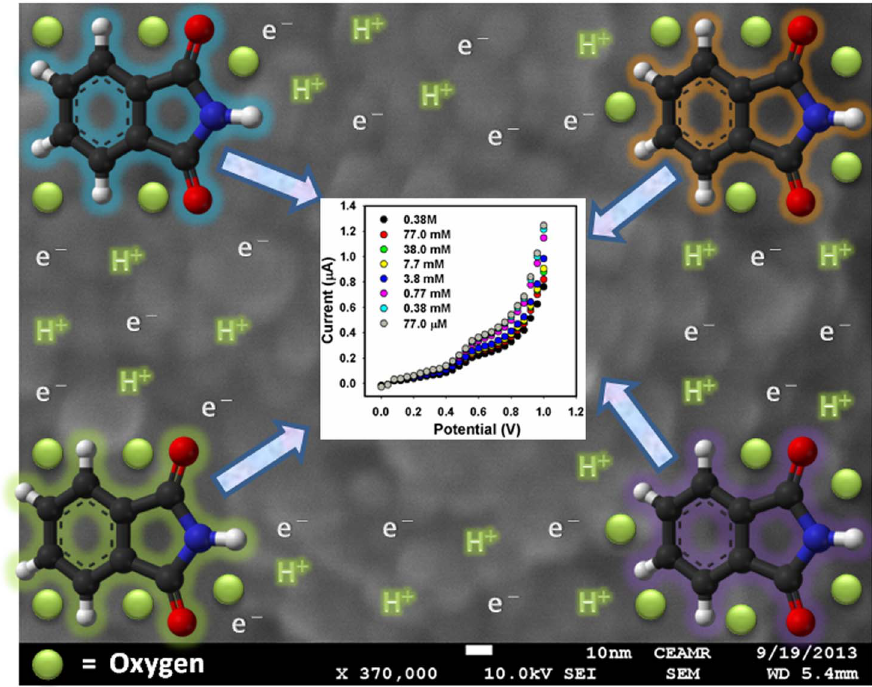
Figure 7. Schematic views of the reactions occurred at fabricated electrode for the recognition of phthalimide.